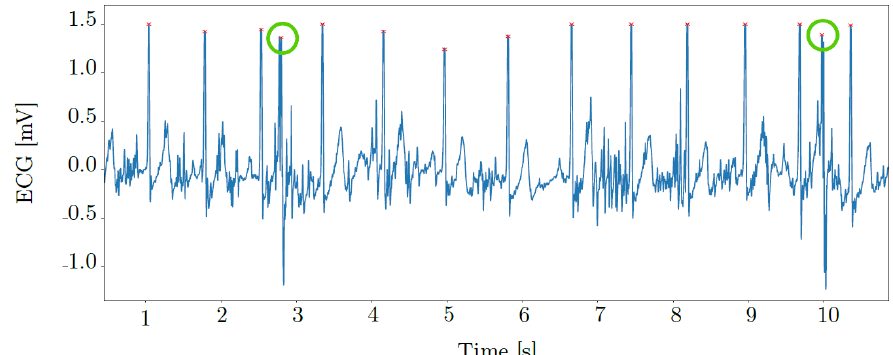
Figure 3. Example ECG-signal snippet from the data recording of subject S1. The two encircled R-peaks were falsely identified by the R-peak detector, and were thus manually removed during heart rate ground truth